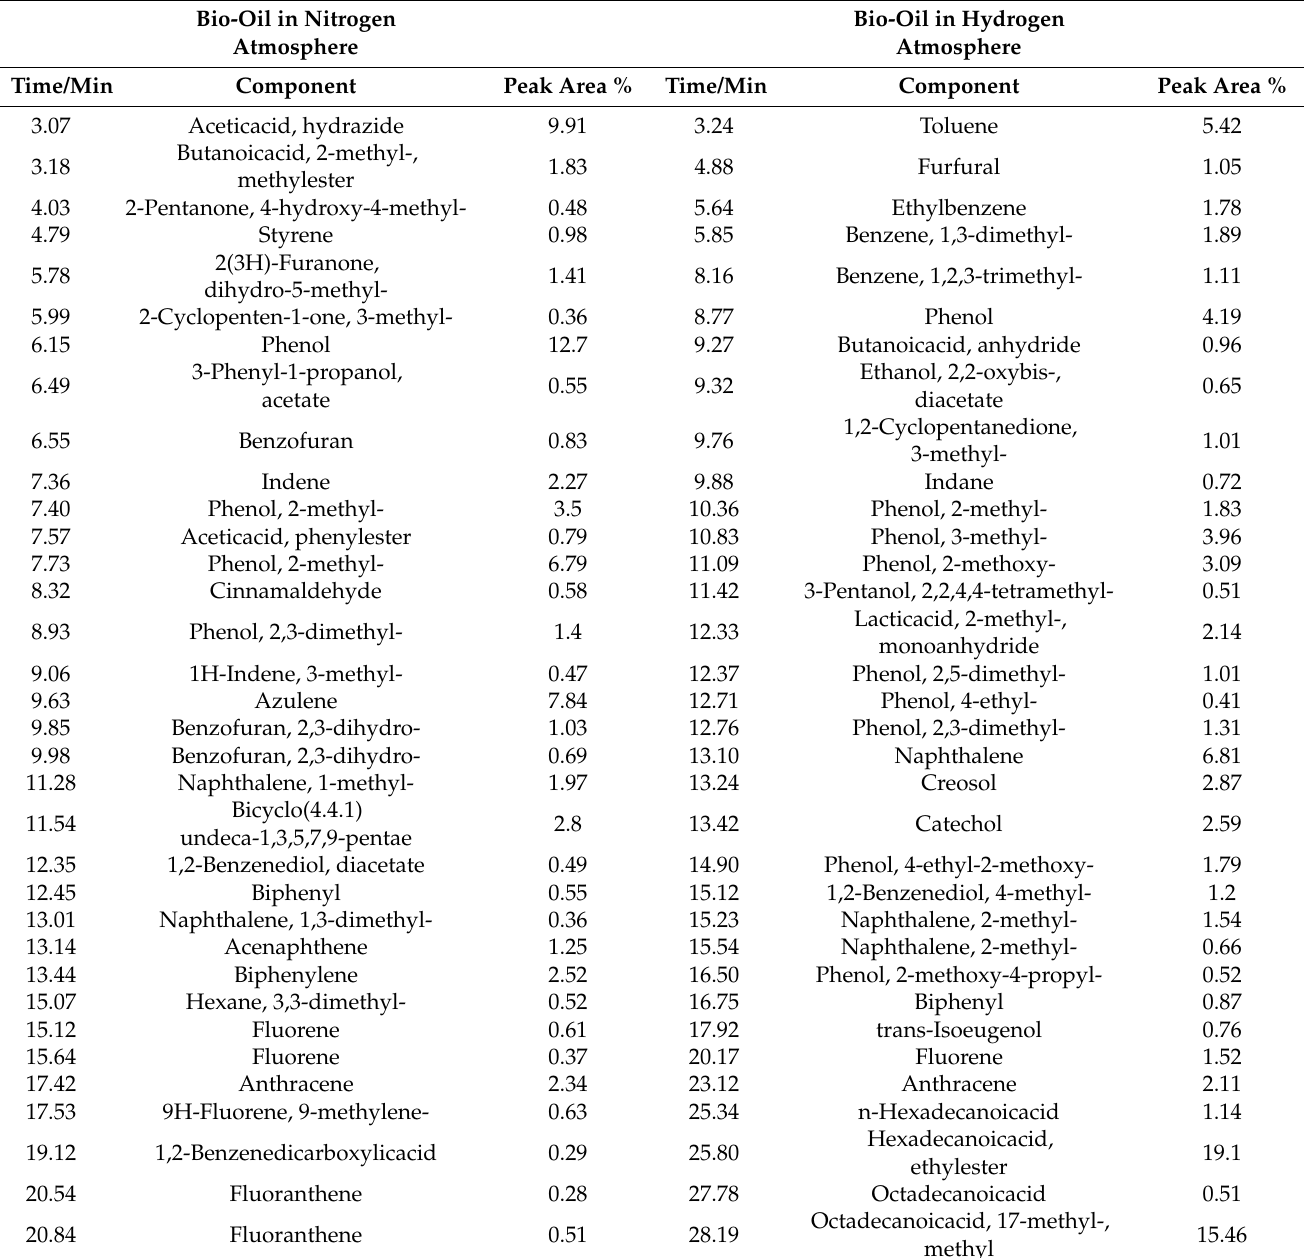
Table 2. Composition of bio-oils in different